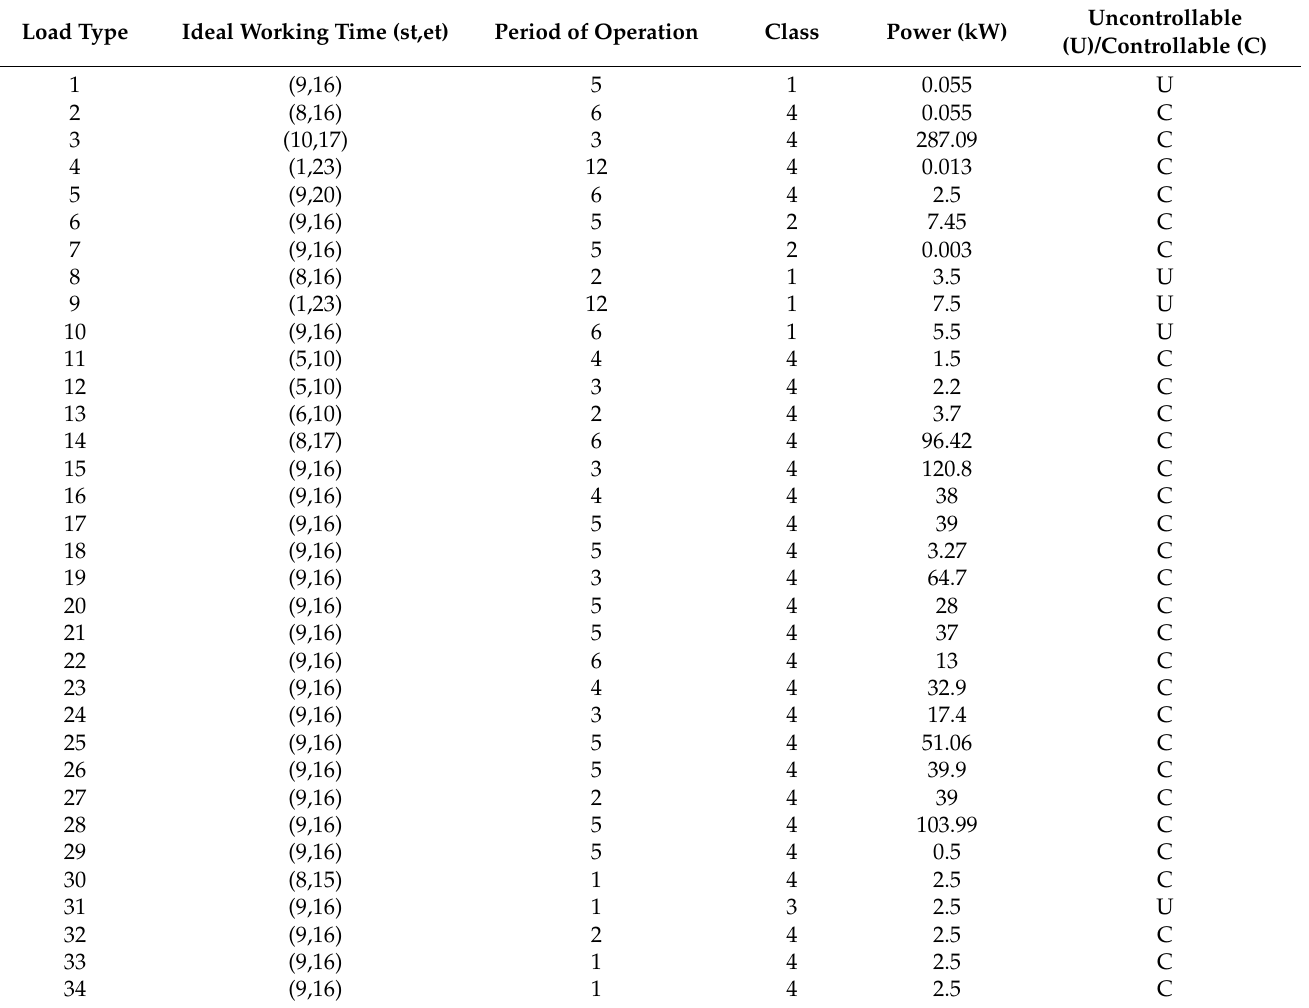
Figure 3. Classification of load types. Table 1. Load types and their parameters